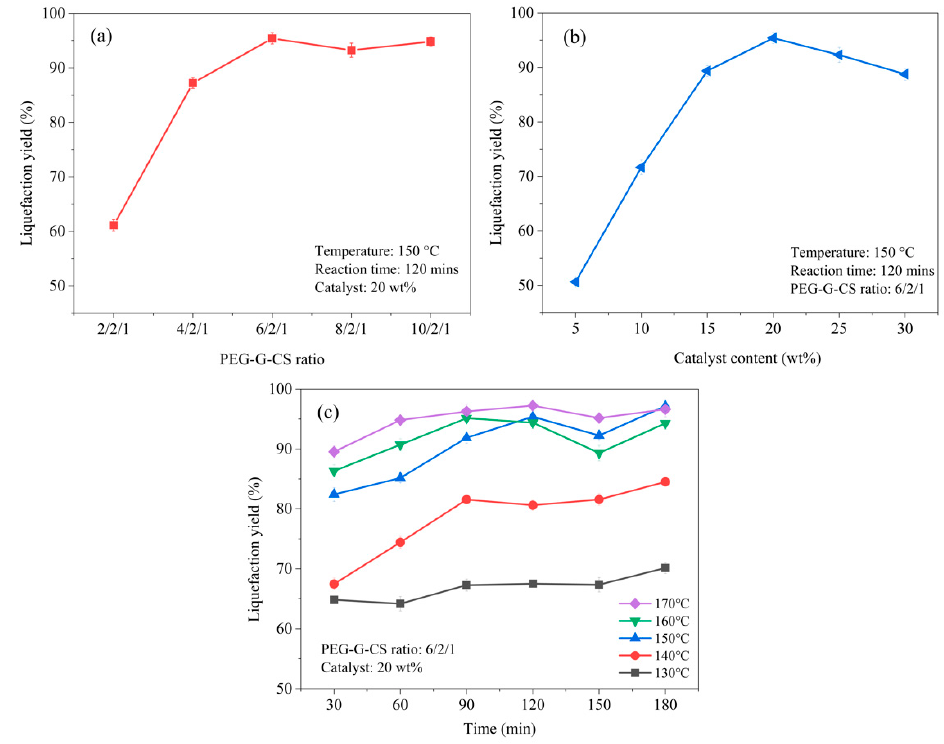
Figure 2. The liquefaction yield of corn stalk (CS) under different reaction conditions of the mass ratio of PEG400, glycerol and CS (PEG–G–CS ratio) ( a ), catalyst content ( b ), reaction temperature and time ( c ).